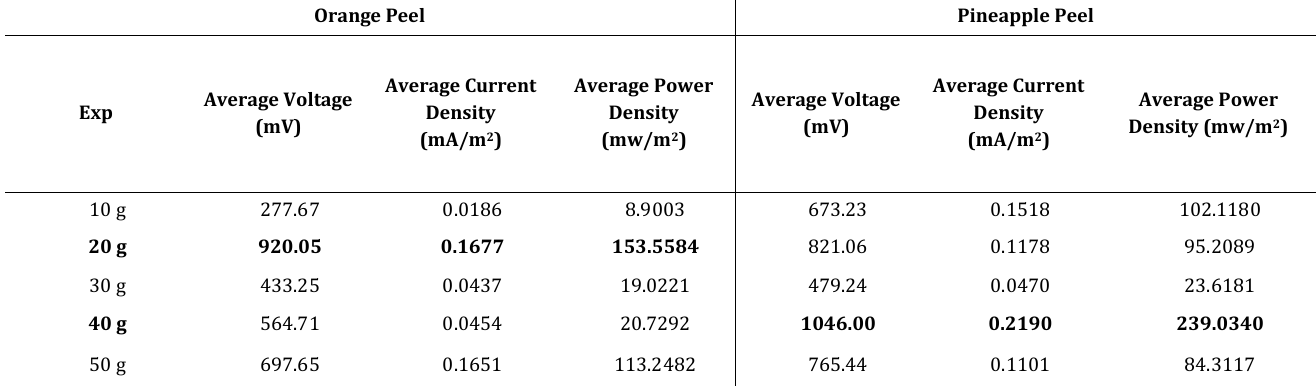
Table 4: Effect of the organic waste on performance of biological cathodic protection system Orange Peel Pineapple